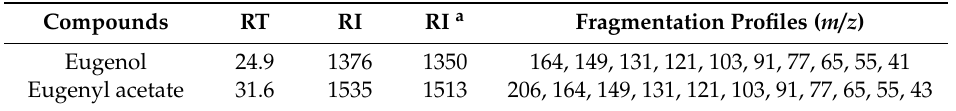
Table 8. Chemical characterization of eugenol and eugenyl acetate by gas chromatography-mass spectrometry (GC-MS).